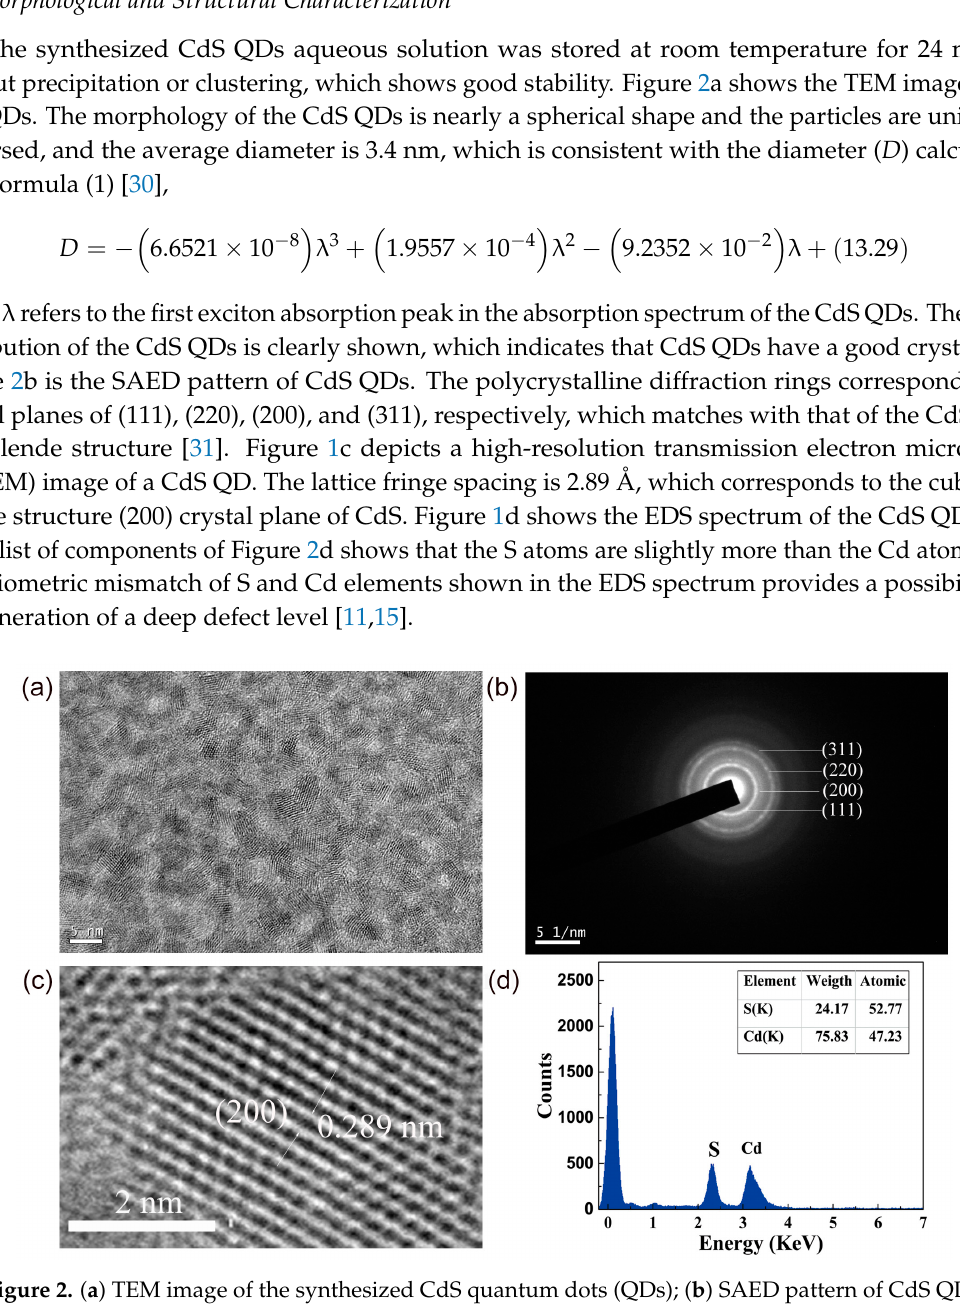
Figure 2. ( a ) TEM image of the synthesized CdS quantum dots (QDs); ( b ) SAED pattern of CdS QDs, the relevant crystal planes are indexed in the figure; ( c ) HRTEM image of a single QD that displays (200) crystal plane lattice fringes; ( d ) EDS spectrum of CdS QDs in our experiments.